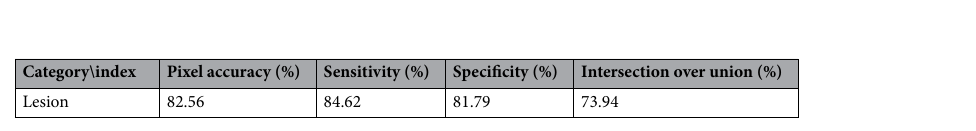
Table 6. The segmentation performance of lesion samples for the binary classification task. Lesion samples achieves 82.56% pixel accuracy, which is consistent with the detection performance in Table 5.